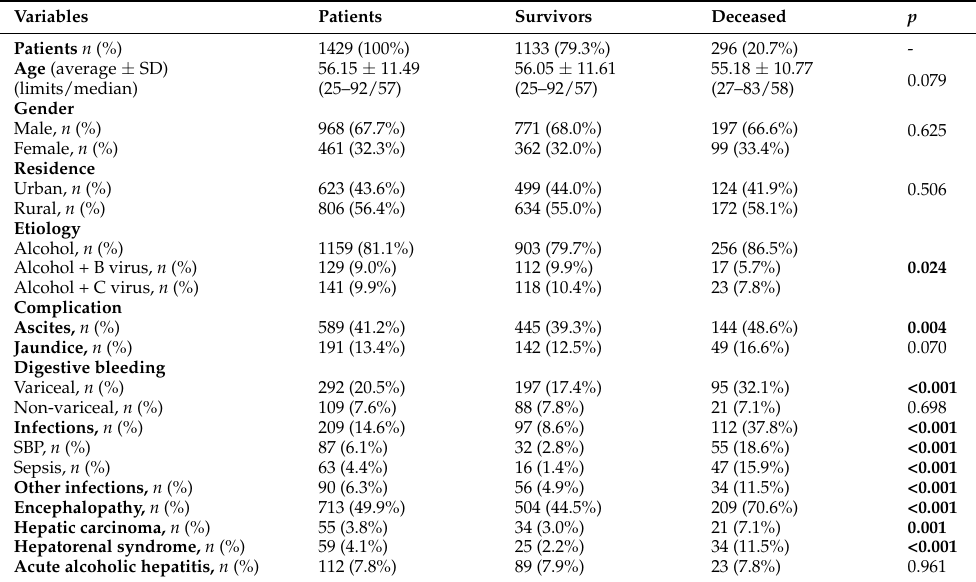
Table 1. Demographic and clinical data of the investigated